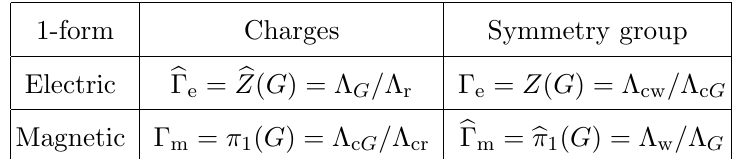
; (cid:0) , the (co)weight lattices (cid:3) ; (cid:3) , and the one-form e m G c G gauge theory. In particular (cid:0) = Z ( G ) m e = m